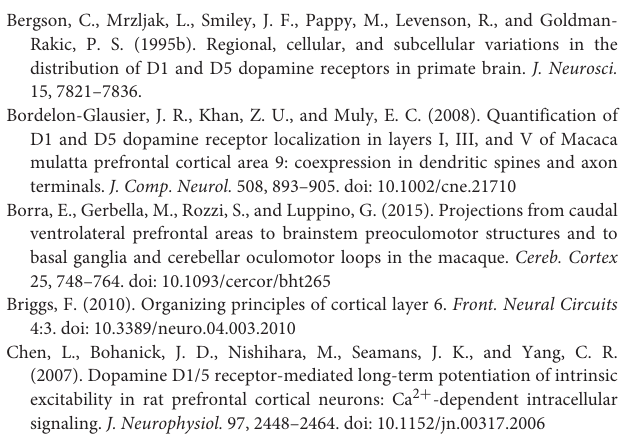
FIGURE S1 | D5 class of dopamine receptor (D5R) antibody specificity controls. (A) Western blot of D5R antibody. D5Rs are present on white blood cells, which are found in the serum of a routine blood draw. We performed a western blot using three volumes of the extracted macaque serum and consistently found the Almone D5R antibody stained one major band at approximately 44 kD. Macaque D5R is theoretically predicted to have a molecular weight of 52.9 kDa. Proteins often do not run exactly at their predicted weight due to post-translational modification such as phosphorylation or glycosylation, which can cause different mobilities on SDS-PAGE. Proteins can also appear at lower positions than expected due to partial digestion by enzymes. (B) Preadsoprtion control of D5R antibody. Two neighboring sections of FEF were stained with the Alomone D5R antibody. The left section was stained using the described methods. The right section was stained after preadsorbing the same volume of antibody (500 µ l at 1:200) with D5R antigen supplied by Alomone (40 µ g) overnight at 4 ◦ C. After preadsorbption no staining is visible on the section—indicating a lack of non-specific binding. Scale bars = 200 µ